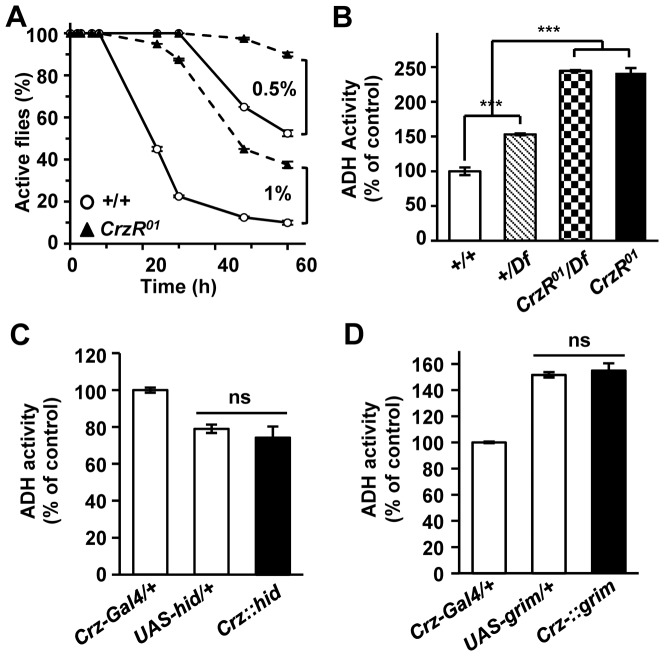

CrzR mutation causes significant increase of ADH activity.(A) Survival rates of CrzR01 (dashed lines) and wild-type (solid line) in response to acetaldehyde as indicated (n = 3). (B) Histogram showing ADH activity (n = 4). (C,D) ADH activity in Crz-CD. (C) hid- and (D) grim-induced Crz cell ablation did not increase the whole cell ADH activity (P > 0.05, n  =  3). (*** P<0.001). Each data point represents mean ± sem for the indicated replicates. All genotypes are in y w background.